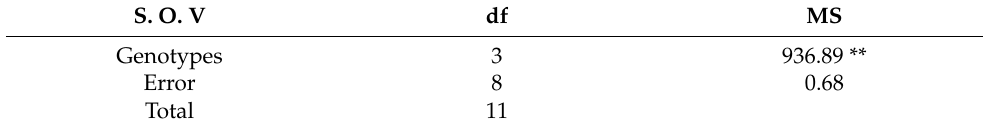
Table 4. Analysis of variance of TCL (Total Chromosome Length) in P. vulgaris L.